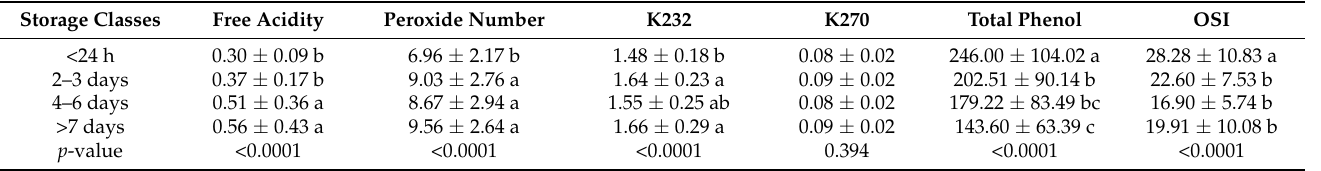
Table 1. Quality index of oil samples extracted after different olive storage duration. Values are mean ± standard deviation. Values followed by different letters in the same column (a, b, c) were significantly different according to Tukey’s test ( p <